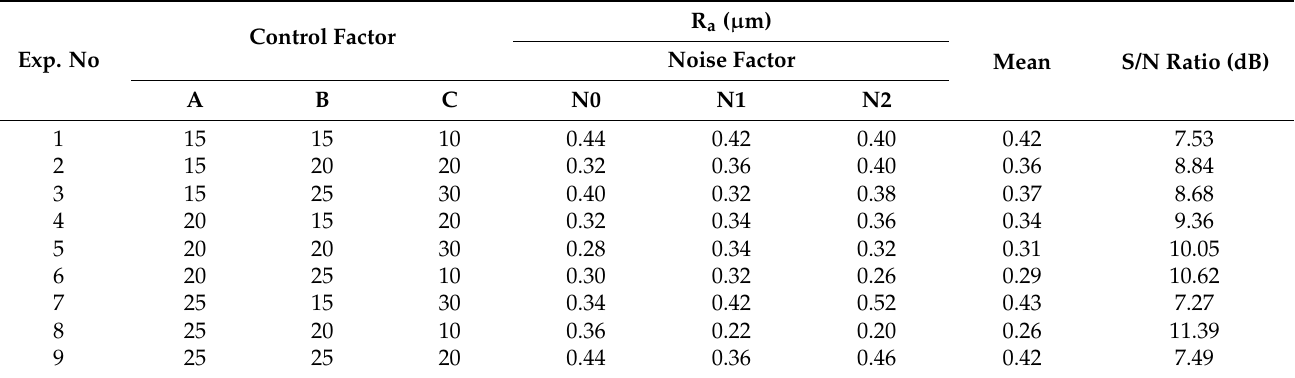
Table 7. Surface roughness and S/N